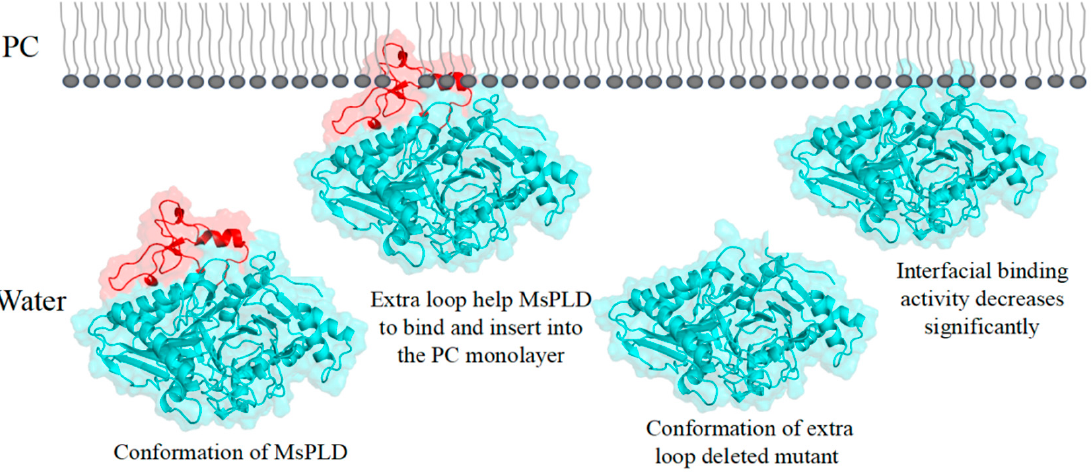
Figure 7. Schematic model of interfacial binding of wild type MsPLD and its truncated mutant to the PC monolayer. Proposed anchor role of extra loop segment on MsPLD binding to the PC monolayer. The extra loop of MsPLD is marked in red.